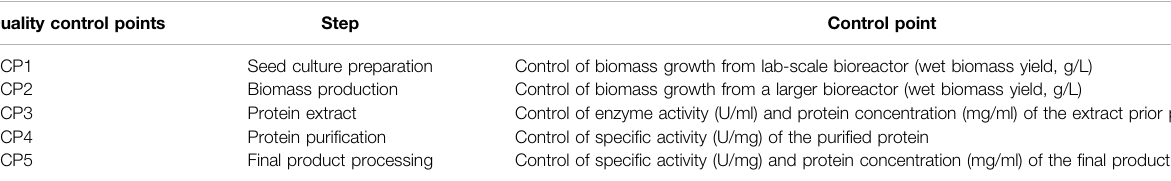
TABLE 1 | Quality control points (QCP) de fi ned for enzyme production. Quality control points Step Control point